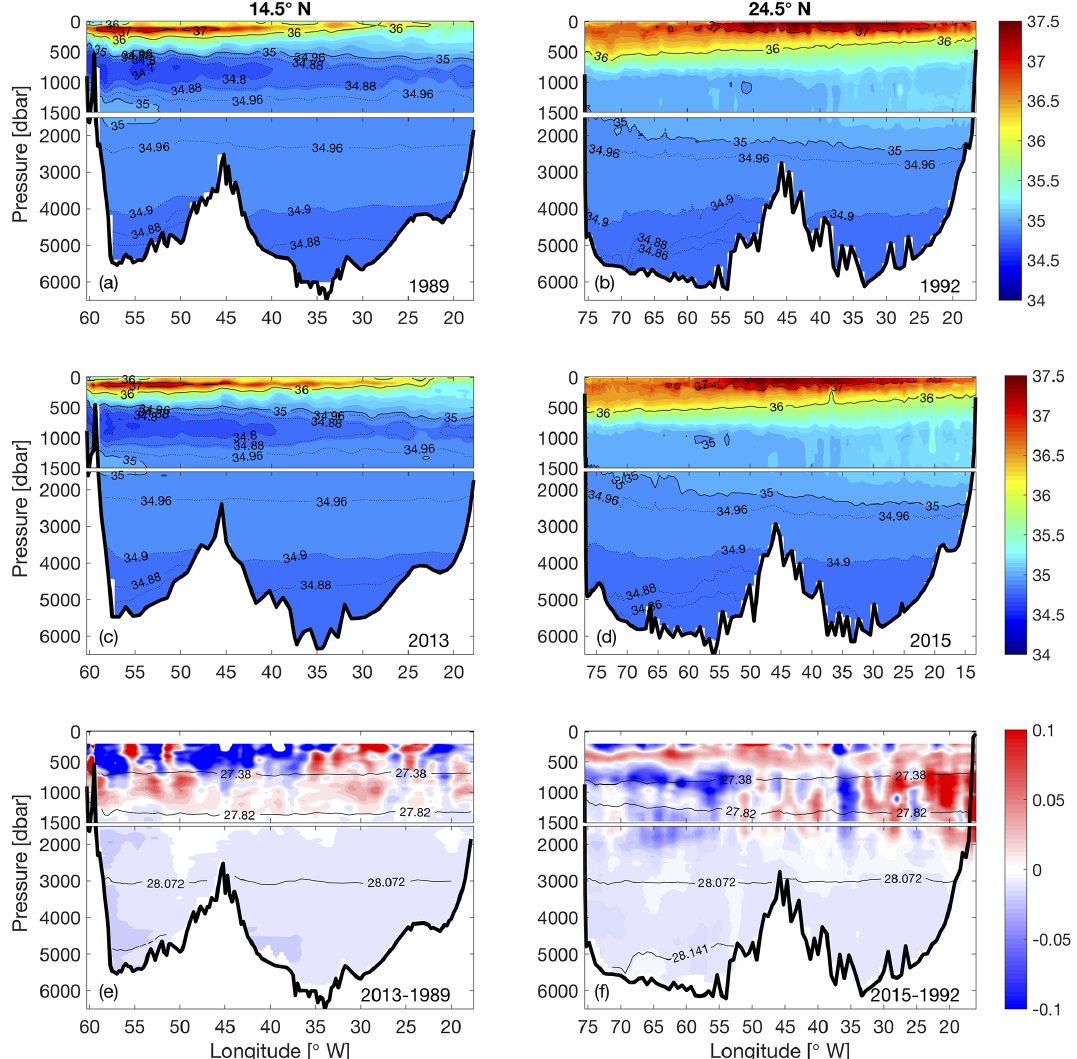
Figure 3. Vertical sections of salinity at 14.5 ◦ N in (a) 1989 and (c) 2013 and at 24.5 ◦ N in (b) 1992 and (d) 2015. Further shown is the salinity difference at (e) 14.5 ◦ N between 2013 and 1989 and (f) at 24.5 ◦ N between 2015 and 1992. Note that the difference is calculated first on neutral density levels and then transformed back onto depth levels, and that the upper 200m is neglected. The contours in (e) and (f) are the neutral density surfaces of 27.38, 27.82, 28.072, and 28.141kgm − 3 , which mark the boundaries of AAIW, UNADW, LNADW, and AABW. The upper 1500m in each subplot is